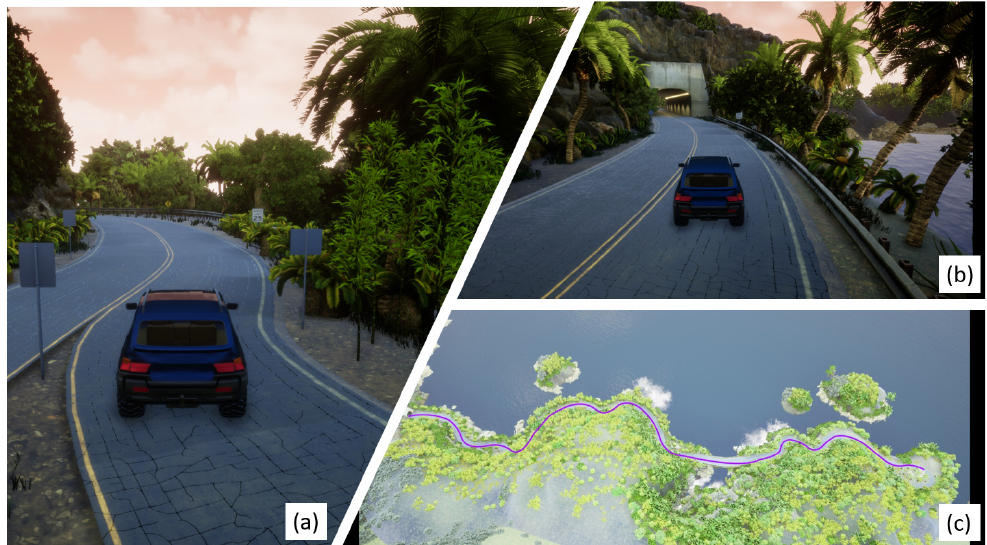
Figure 11. ( a ) The starting point on the training path on the Coastline map; ( b ) the destination on the training path on Coastline map; ( c ) the training path on Coastline